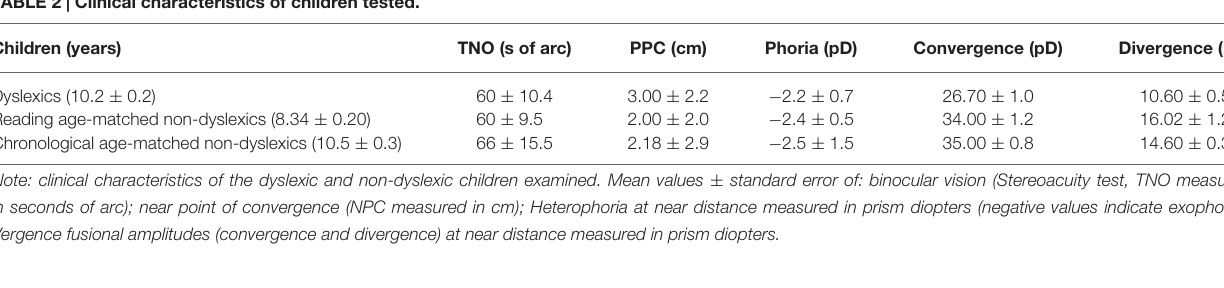
Data were analyzed using the linear regression models for the three groups of children separately (dyslexic and chronological and reading age-matched non-dyslexic); dependant variable was the number of saccades measured during fixation task and